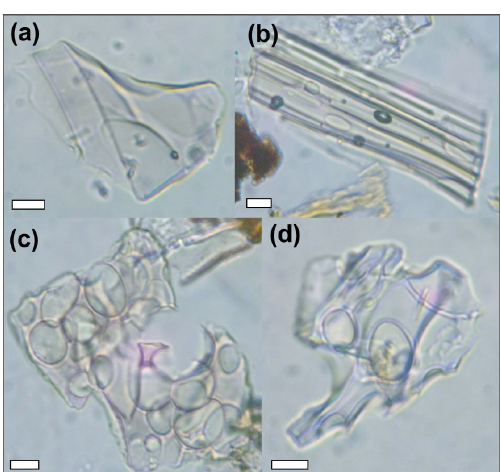
Figure 4. Light microscope images illustrating tephra shards found in Europe: ( a and d ) Glen Garry tephra, N. England; ( b and c ) Hekla-Selsund tephra, Shetland Isles. The tephra shards have dif- ferent morphological characteristics: (a) platy; (b) pulled; (c) bub- bly; (d) bubbly and platy. Their optical and aerodynamic properties are unlike dense spheres. Scale bars are 10µm in